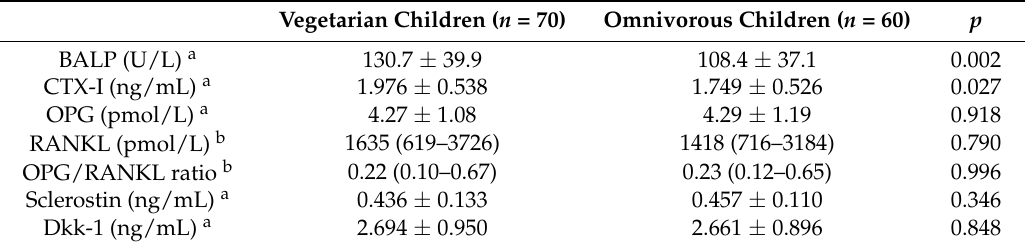
Serum concentrations of biochemical bone metabolism markers in vegetarian and omnivorous children.